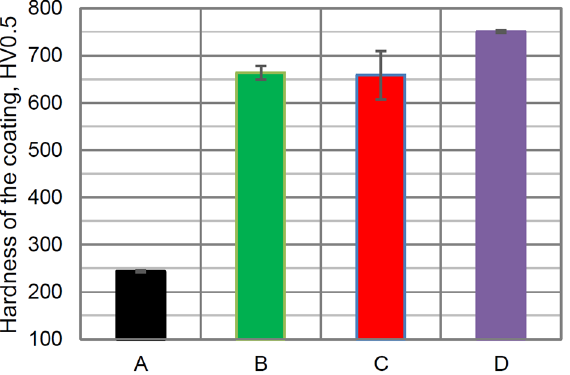
Figure 9. The hardness of pure cast-iron cylinder liner (A) and plasma-sprayed coatings using: pure SJA 175 powder (B) with 5 wt. % (C) and 10 wt. % (D) addition of YSZ powder. SJA 175 powder (B) with 5 wt. % (C) and 10 wt. % (D) addition of YSZ